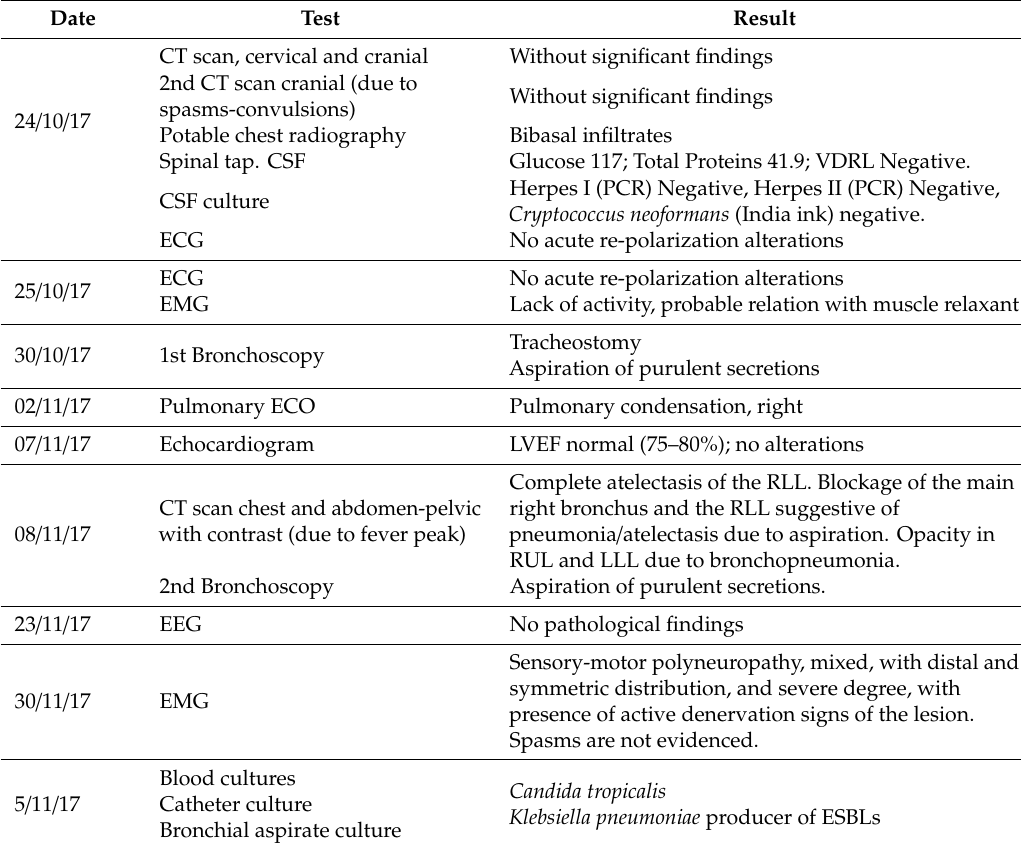
Table 1. Complementary tests performed during the hospital